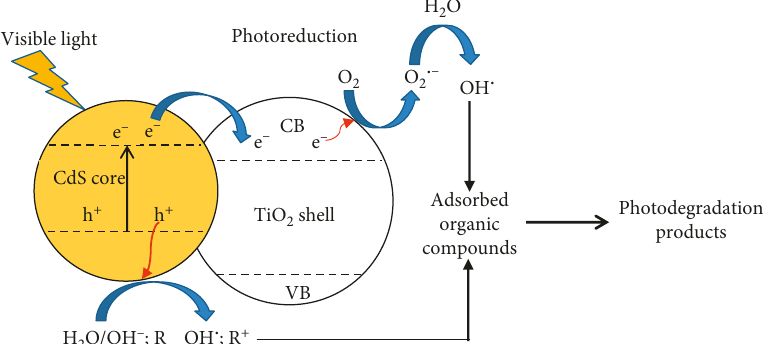
Figure 7: Proposed photoinduced electron-hole pair formation mechanism at the CdS-TiO